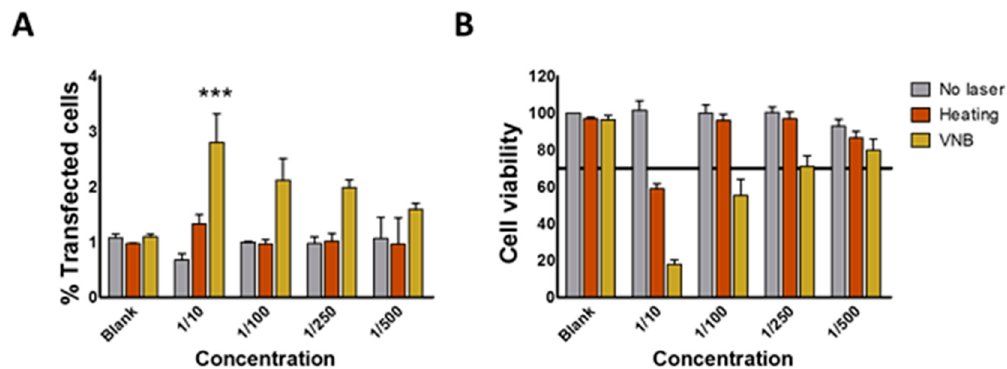
Figure 7. Evaluating transfection efficiency and cell viability in HeLa cells after laser irradiation in the heating or VNB regime. ( A ) the graph shows the percentage of cells that are positive for GFP transfection for different dilutions of JetPEI/pDNA/AuNP 5 pt complexes 24 h after laser irradiation; ( B ) the graph shows the corresponding percentage of viable cells as measured by DAPI staining. All graphs show mean ± SEM; n = 3. Significance was calculated using two-way ANOVA with a Bonferroni post-test (compare means to blank) (*** p < 0.001).